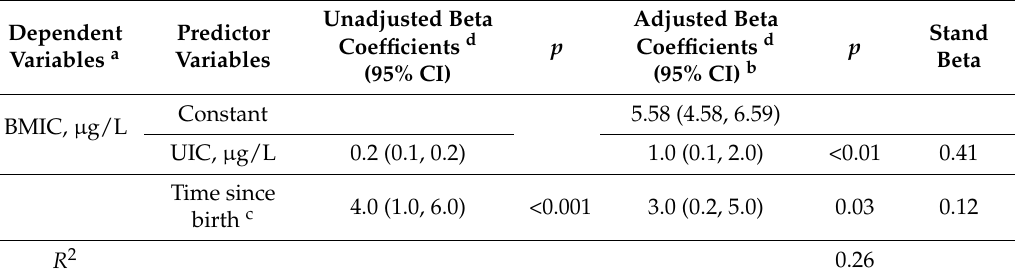
Table 2. Determinants of BMIC among lactating women ( n = 291).